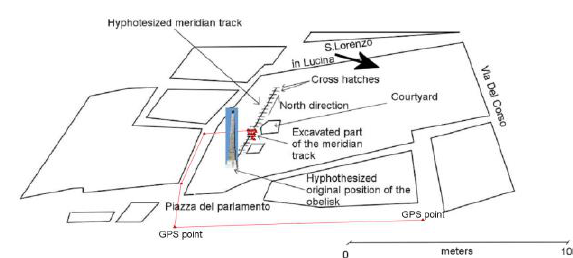
Figure 1. Approximate position of the “Horologium”: present ground level is approximately 6 meters higher than